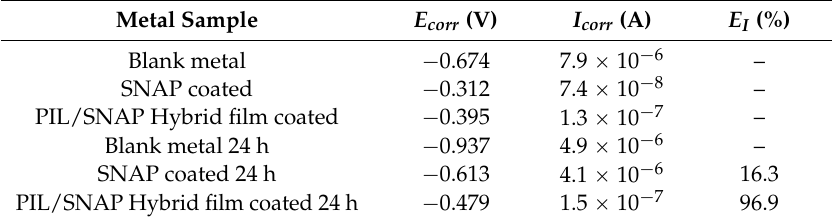
Figure 7. Tafel plot of the SNAP ‐ coated samples with and without the PIL interfacial layer. Table 1. Corrosion potential ( E corr ) and current ( I corr ) of the SNAP-coated samples with and without the PIL hybrid film interfacial